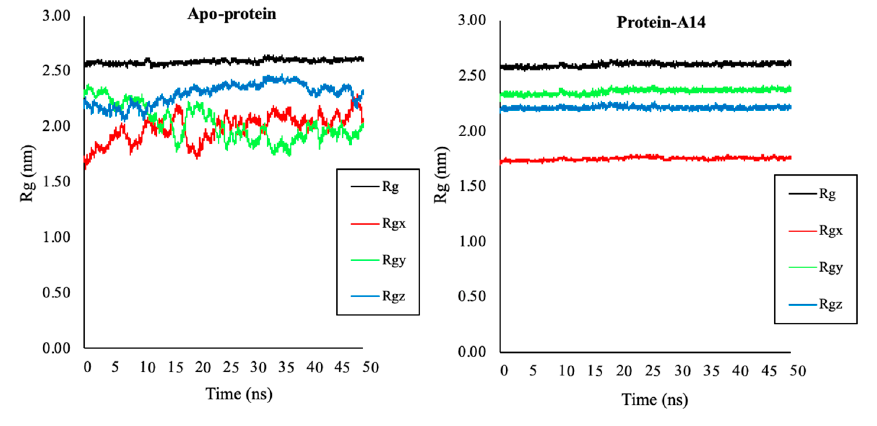
Figure 12. Radius of gyration (Rg) of protein 1LPB in apo ‐ protein and protein– A14 complex during 50 ns MD simulations: ( a ) Rg of protein in the protein ‐ A14 complex; ( b ) Rg of protein in the apo ‐ protein. Total Rg of protein was in black, Rgx, Rgy, and Rgz around the x ‐ , y ‐ , and z ‐ axis were in red, green, blue, respectively.